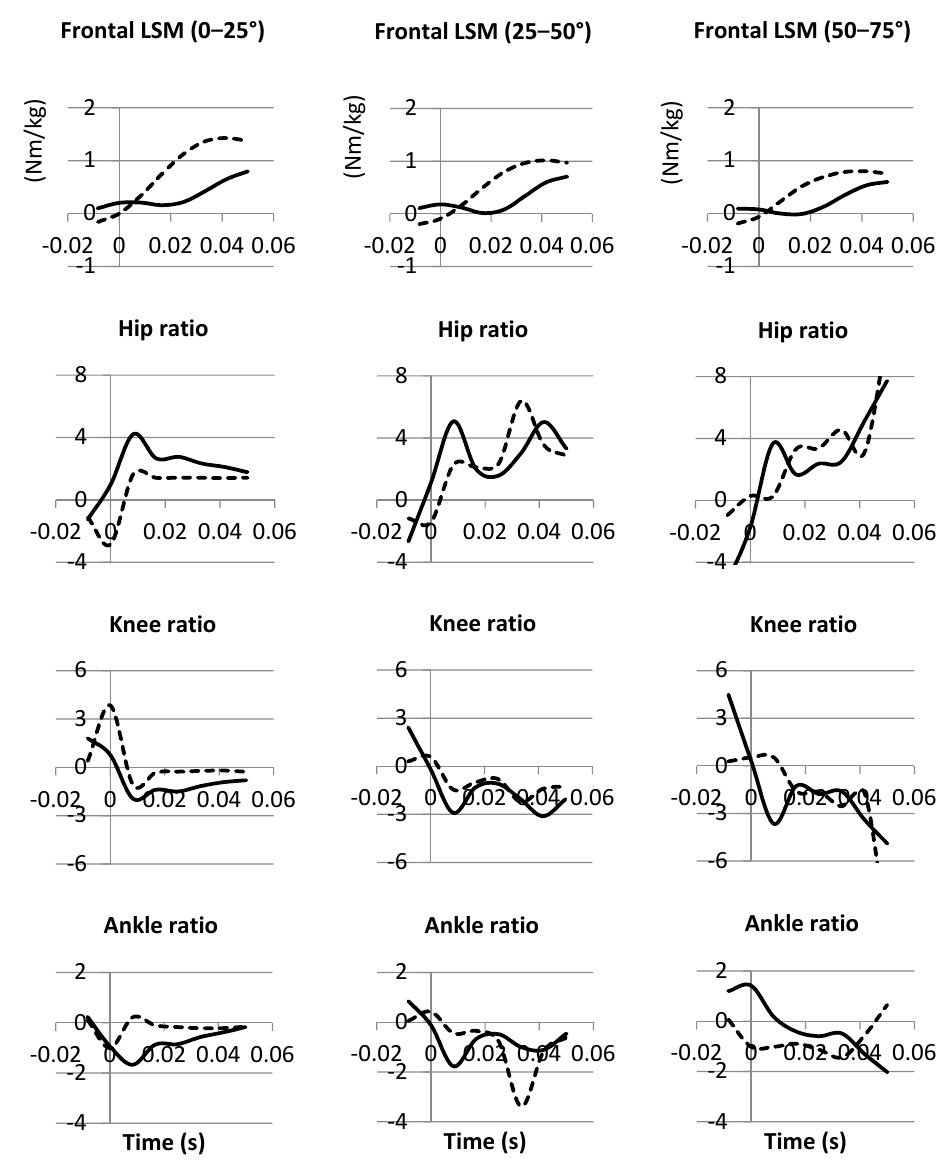
Figure 3. Frontal plane limb support moment sex comparisons with contribution ratios for each landing condition. Male: solid line; female: dashed line. LSM at top: Frontal LSM = MK − MA − MH. Moment ratios at each joint are expressed, relative to the LSM, as contributing (+) or not contributing ( − ) to limb support. Initial contact is 0 s.